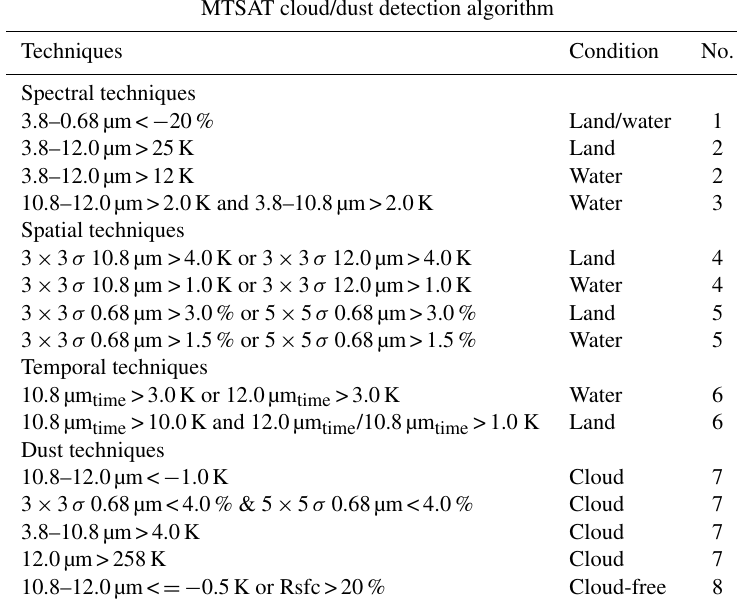
Table 3. MTSAT cloud clearing algorithm with the various techniques and thresholds in the left column; the center column shows the conditions when the techniques are used, and the technique no. relating to cloud/dust detection algorithm results in Fig. 2c is in the right column. The “time” subscript indicates a temporal